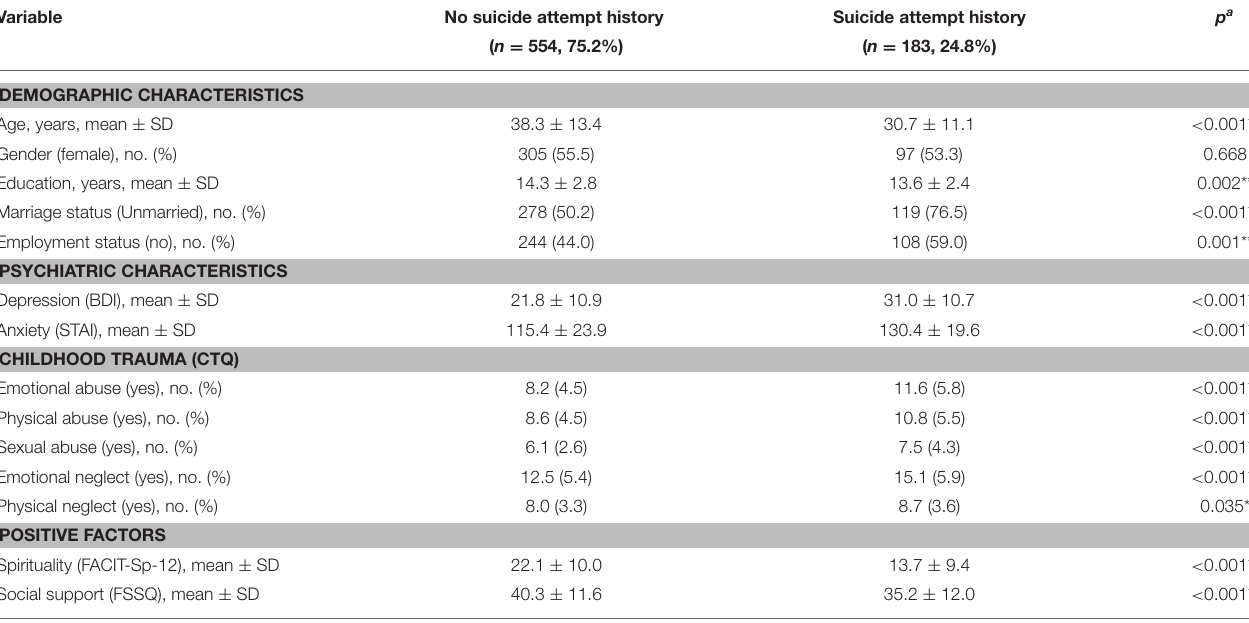
TABLE 1 | Demographic and psychiatric characteristics, childhood trauma, and positive factors of subjects with anxiety and/or depression by suicide attempt history.